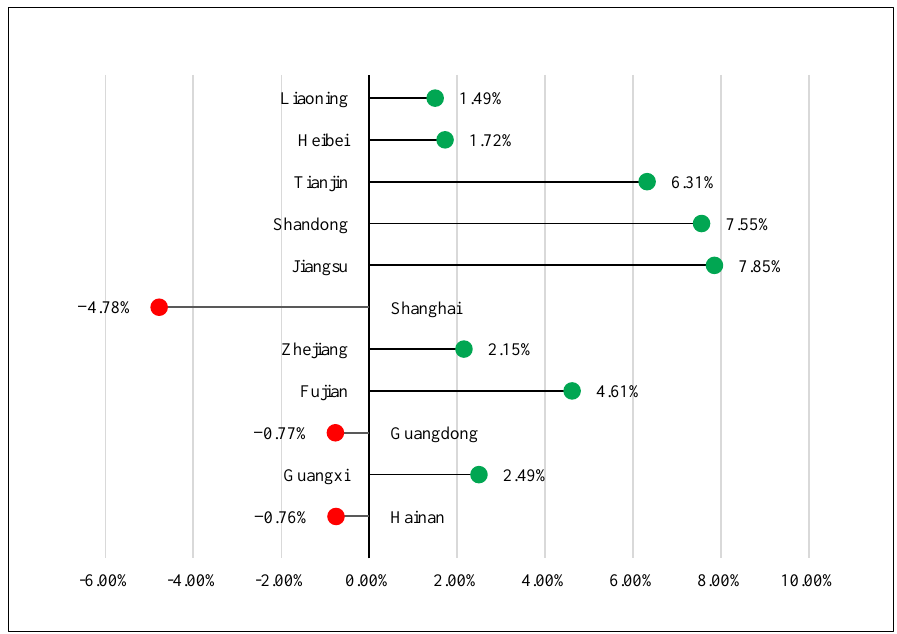
Figure 4. Rate of SUE change in coastal provinces (cities) of China, 2006 – 2018.